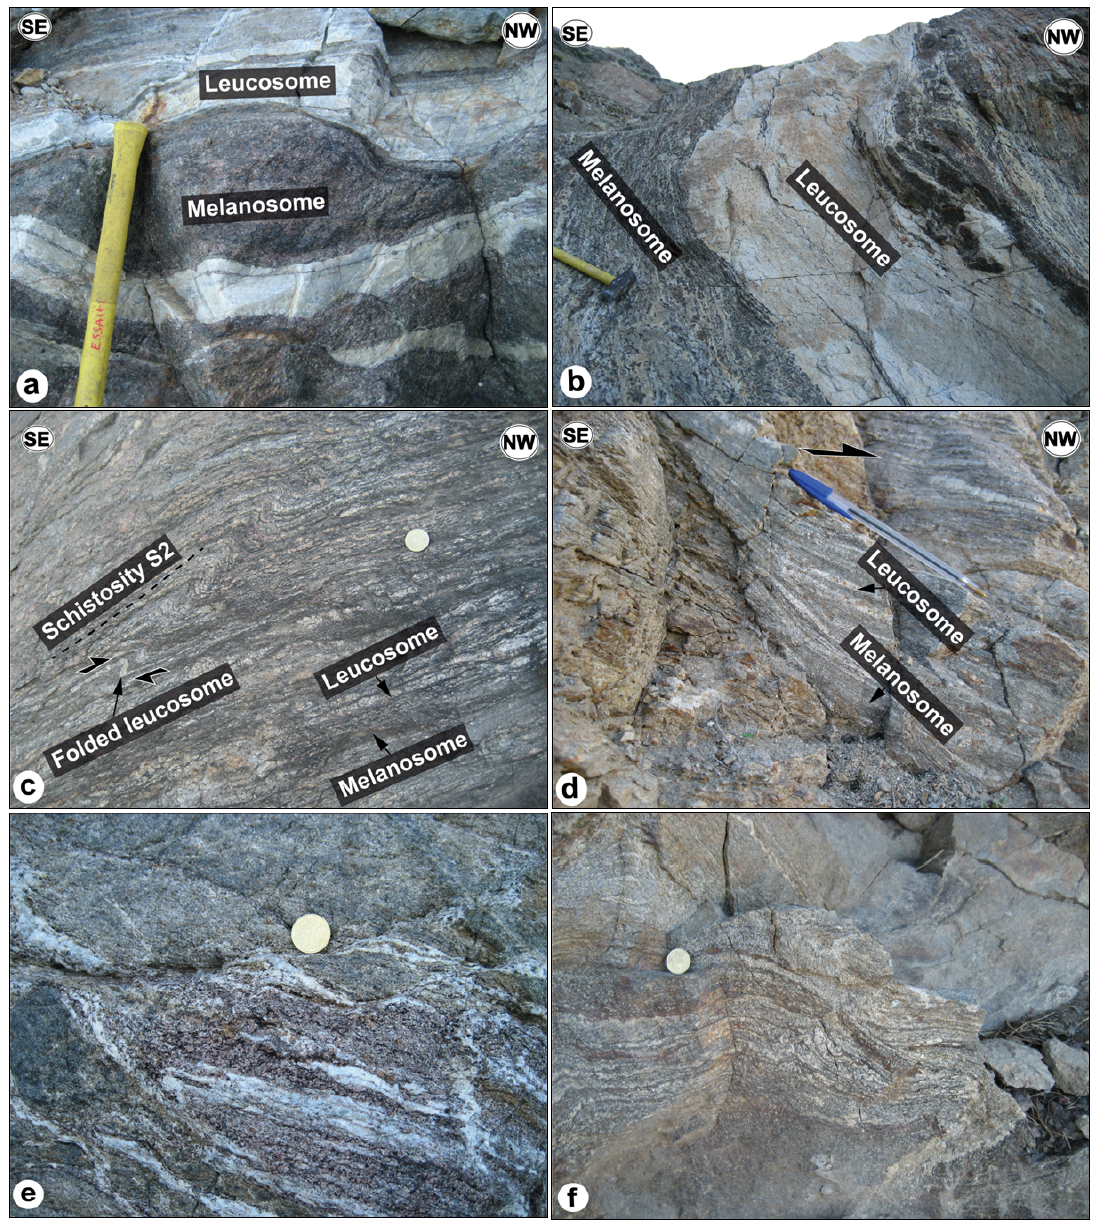
Figure 3. Field photographs showing different geometric relationships between partial melting and main schistosity S2 in the migmatitic paragneisses of the Filali unit. ( a ) Granitic leucosomes parallel to S2 schistosity. ( b ) Aplitic veins oriented parallel to the main schistosity S2. ( c ) Asymmetrical P2 folds overturned to the NW deforming leucosomes. ( d ) Top to the NW shear bands. ( e ) Metabasic levels intercalated in migmatitic paragneisses, boudinaged and surrounded by the main foliation S2. ( f ) Alternating leucosomes and melanosomes; leucosomes are boudinaged, stretched, and parallel to the regional foliation S2.